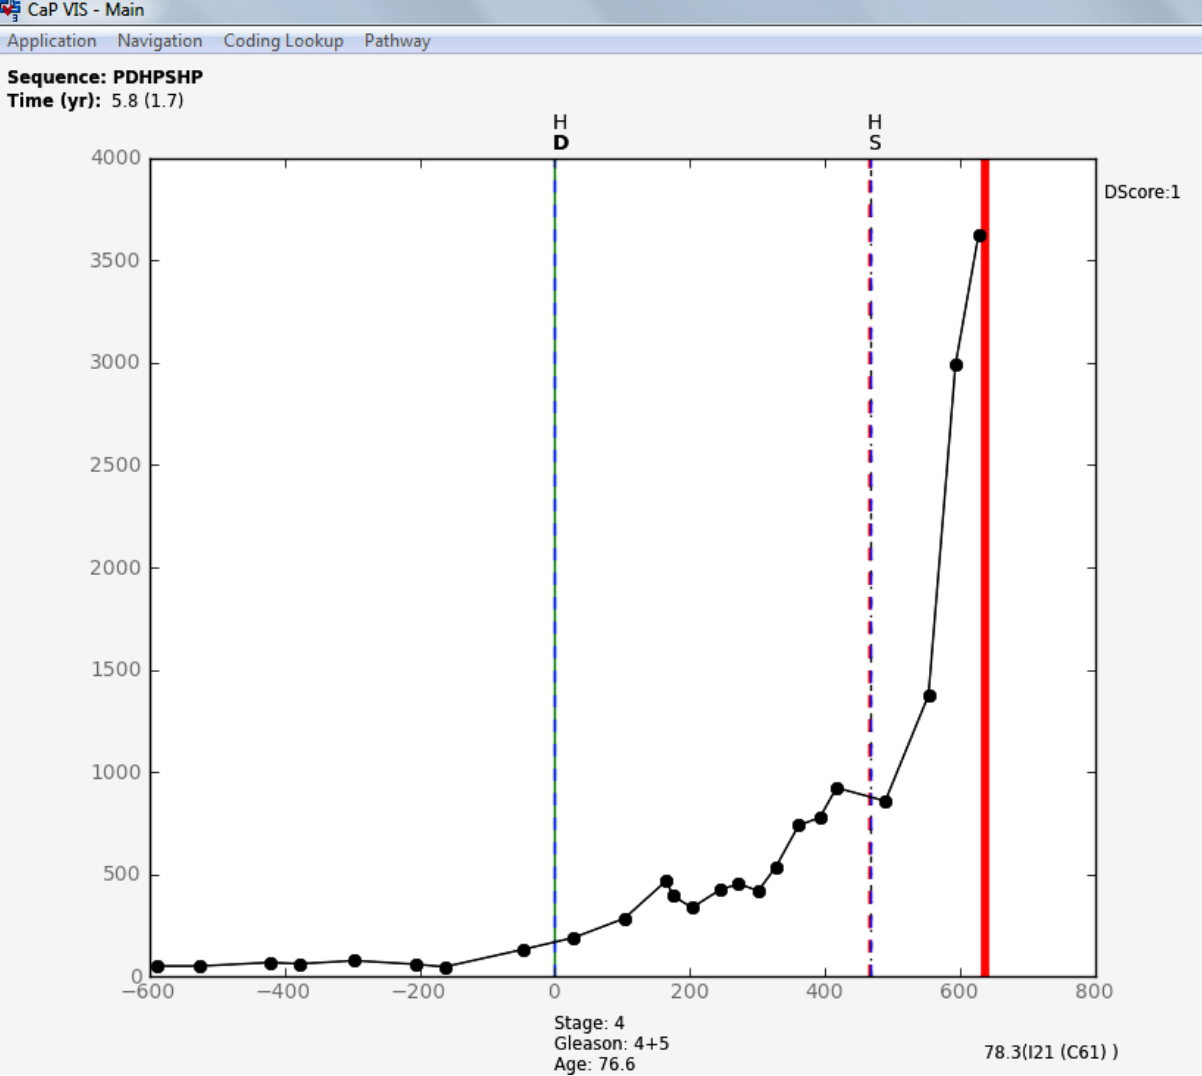
Figure 4. The CaP VIS system showing the left side of the screen with the graphical representation of a castration resistant patient pathway. The patient was first treated with hormone therapy and had a subsequent palliative prostatic resection. The plotted pathway shows the trend of the PSA biomarker together with diagnosis line and